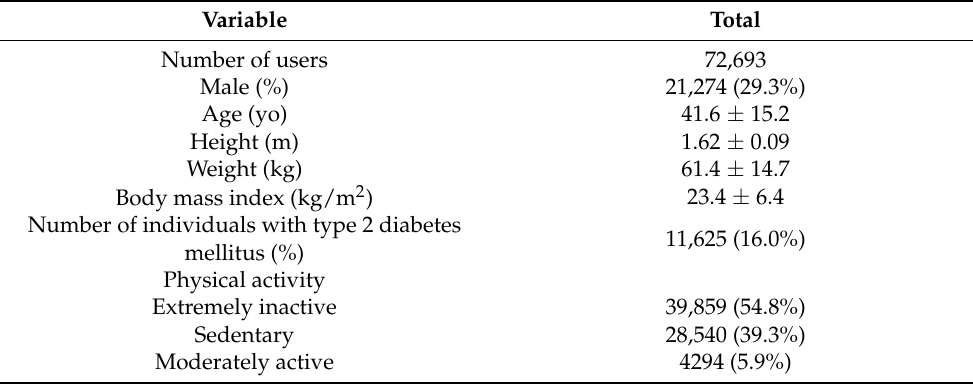
Figure 1. Flow chart of the study datasets. Table 1. Basic characteristics of the study